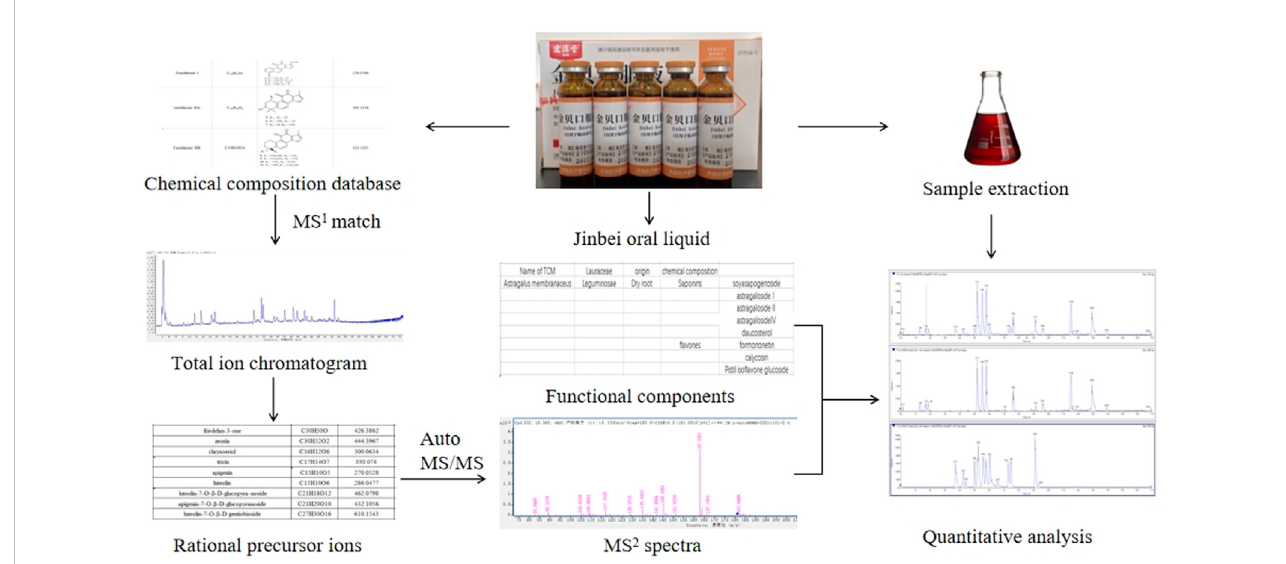
FIGURE 1 Research strategy for identifying the components of Jinbei oral liquid See Supplementary Figure